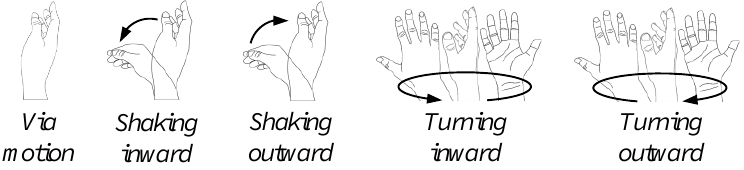
Figure 4. Illustration of five hand-guiding gestures to be classified.